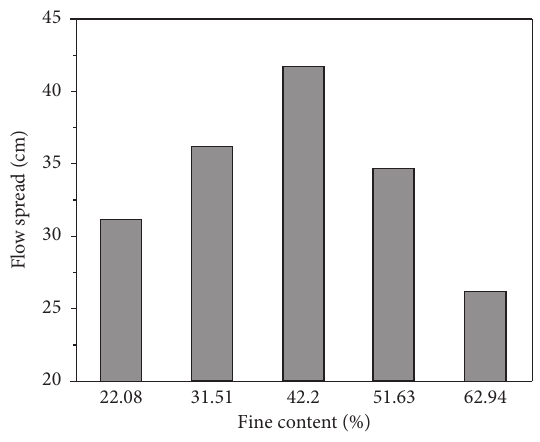
Figure 5: Flow spread variation with fine contents.